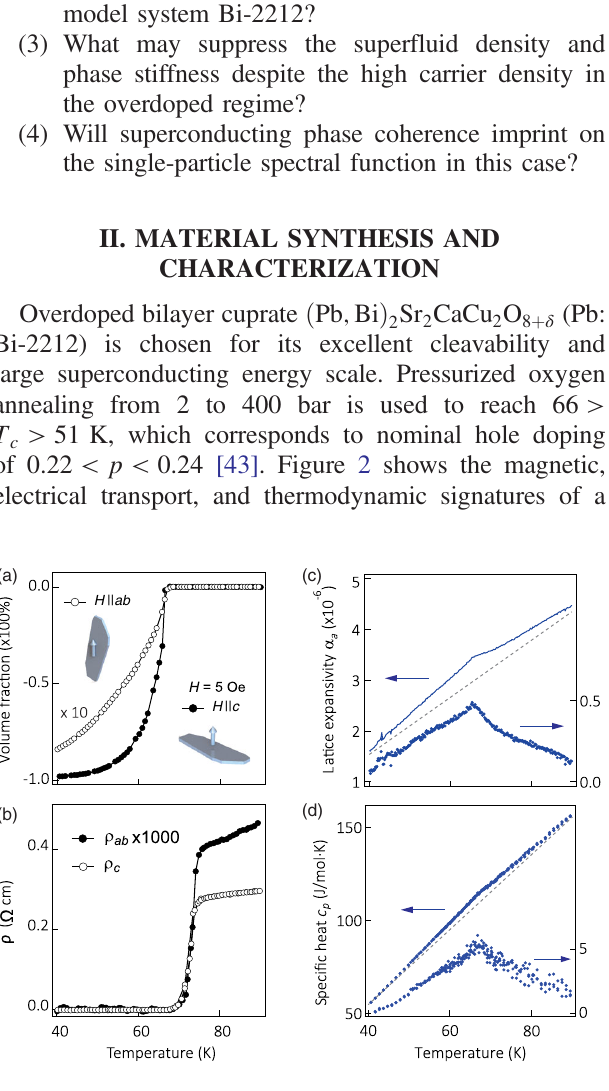
FIG. 2. Bulk magnetic and thermodynamic properties of a ¼ 66 K. (a) dc diamagnetic heavily overdoped Bi-2212 with T c response at 5 Oe, for fields both perpendicular (solid circles) and parallel (open circles) to the CuO 2 plane. (b) In- and out-of-plane resistivity near T . (c) In-plane linear lattice expansion coefficient c α . (d) Molar specific heat c . In both (c) and (d), a linear p background (gray dashed line) is removed to highlight the superconducting transition in the bottom curve plotted to the right axes on an enlarged